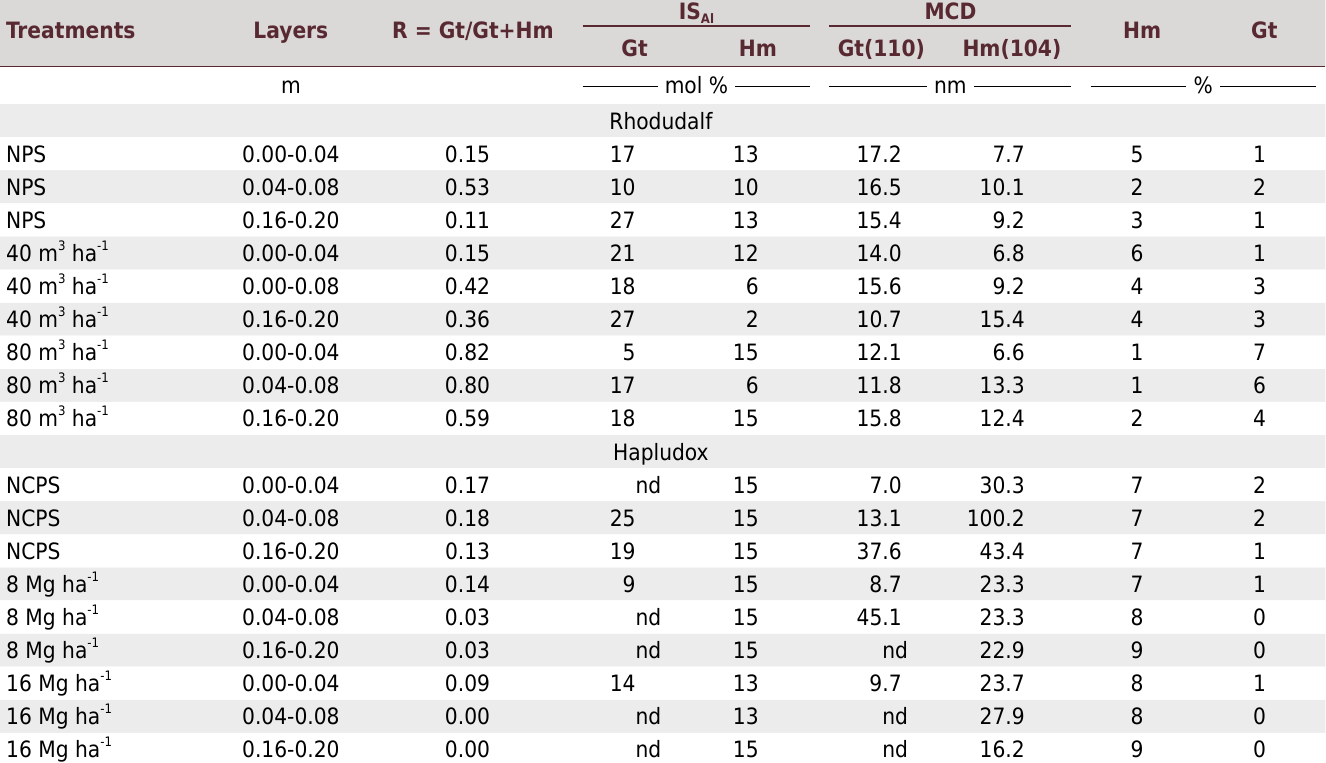
Table 3. Crystallographic data of iron oxides of the Typic Rhodudalf and Typic Hapludox subjected to no-tillage cultivation with long-term organic fertilization Treatments Layers